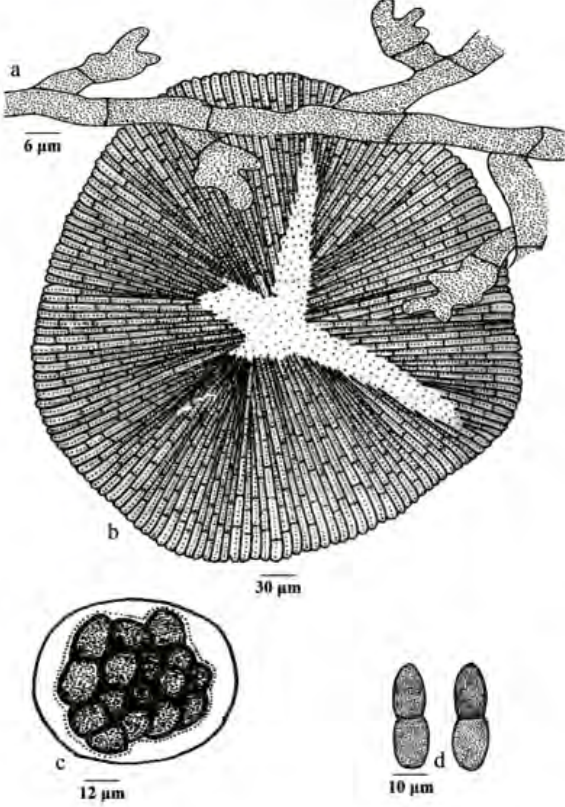
Figure 141. Asterina erysiphoides a- Appressorium; b - Thyriothecium; c - Ascus; d -